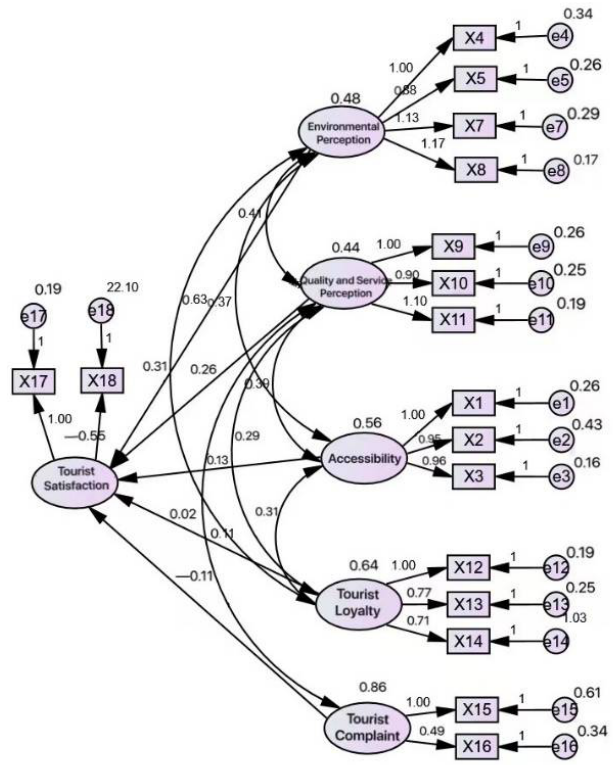
Table 7. Effect path analysis